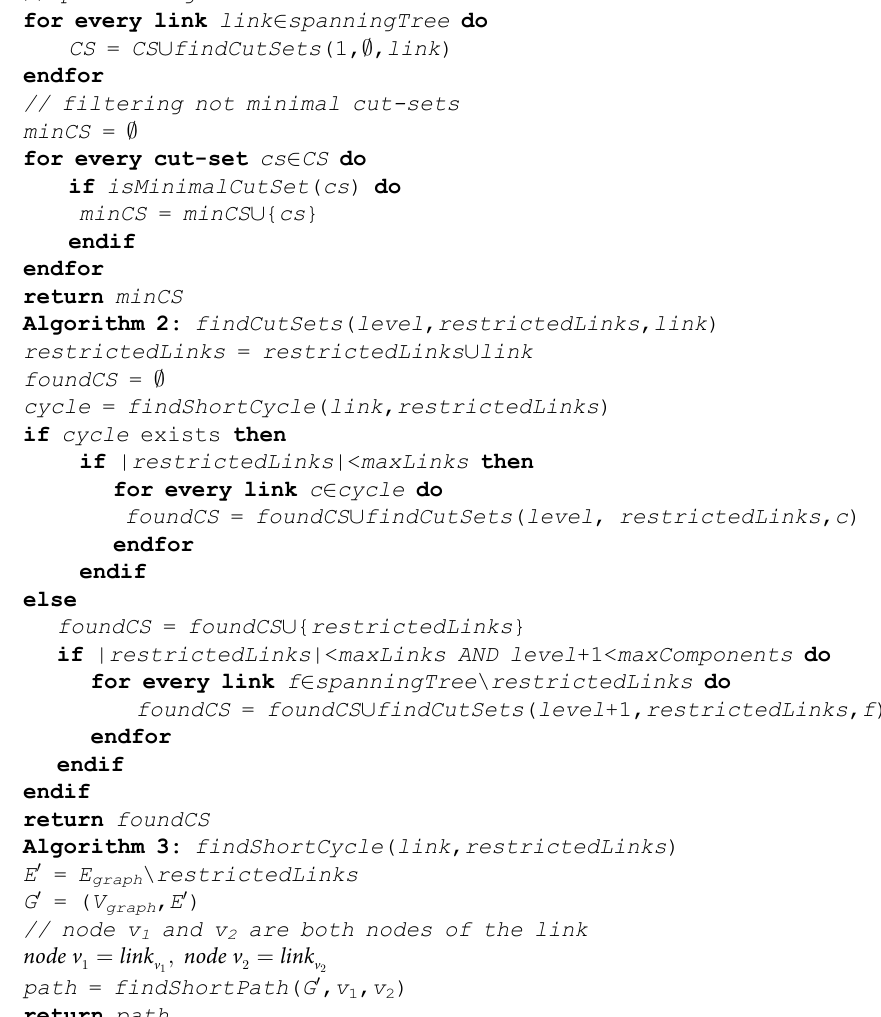
Algorithm 3: findShortCycle ( link , restrictedLinks